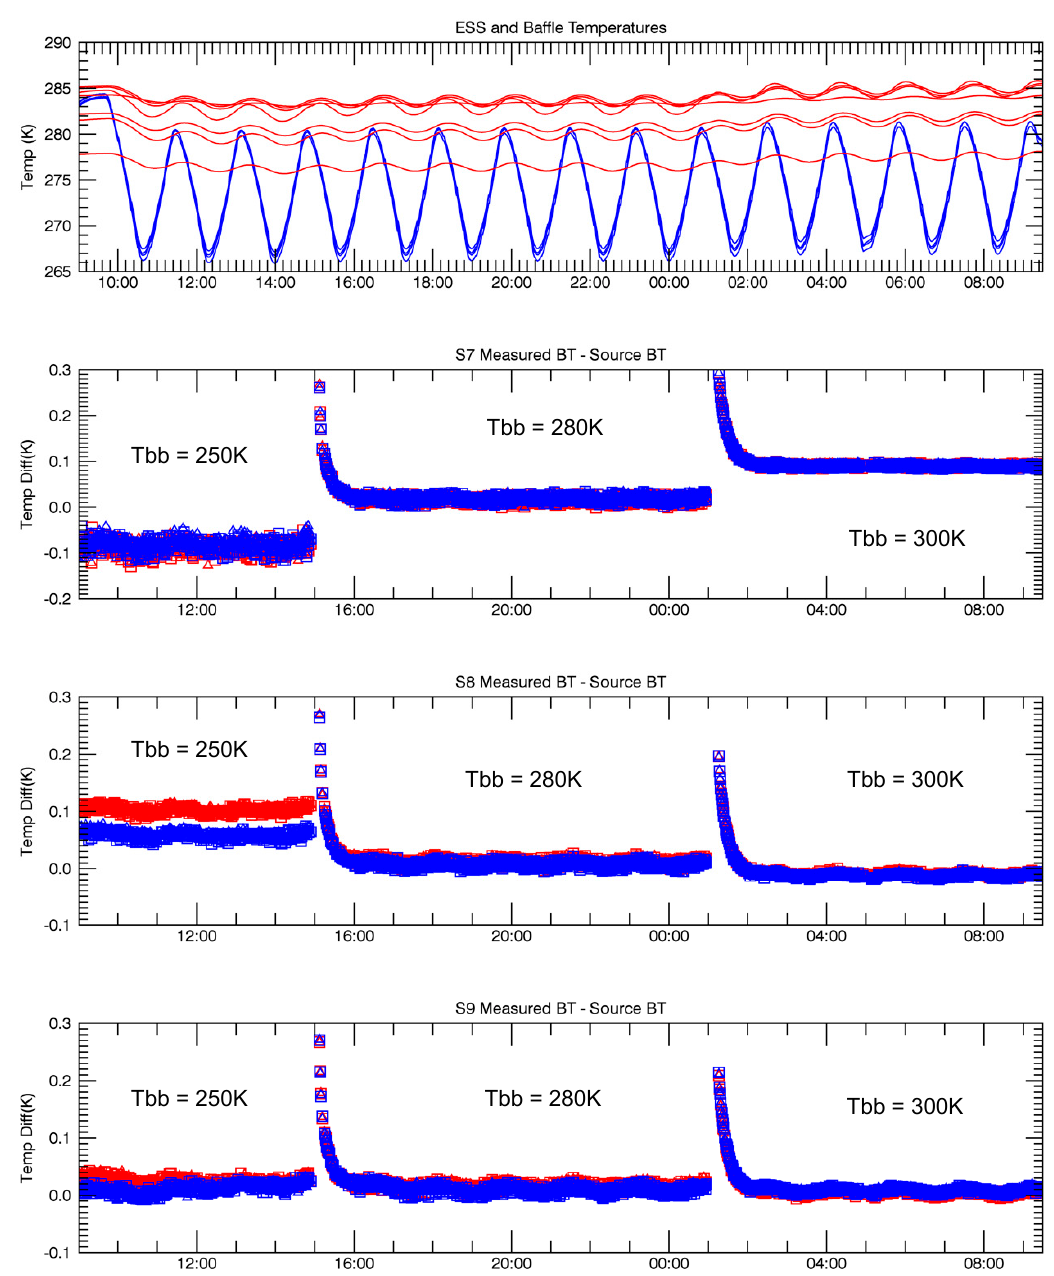
Figure 13. SLSTR-B Orbital simulation results showing the differences between the measured and actual source brightness temperatures. ☐ = Detector 1, Integrator 1; ☐ = Detector 1, Integrator 2; Δ = Detector 2, Integrator 1; Δ = Detector 2, Integrator 2. Error bars are not shown for clarity. Error! Reference source not found. shows the correlation of the SLSTR-A S9 calibration results